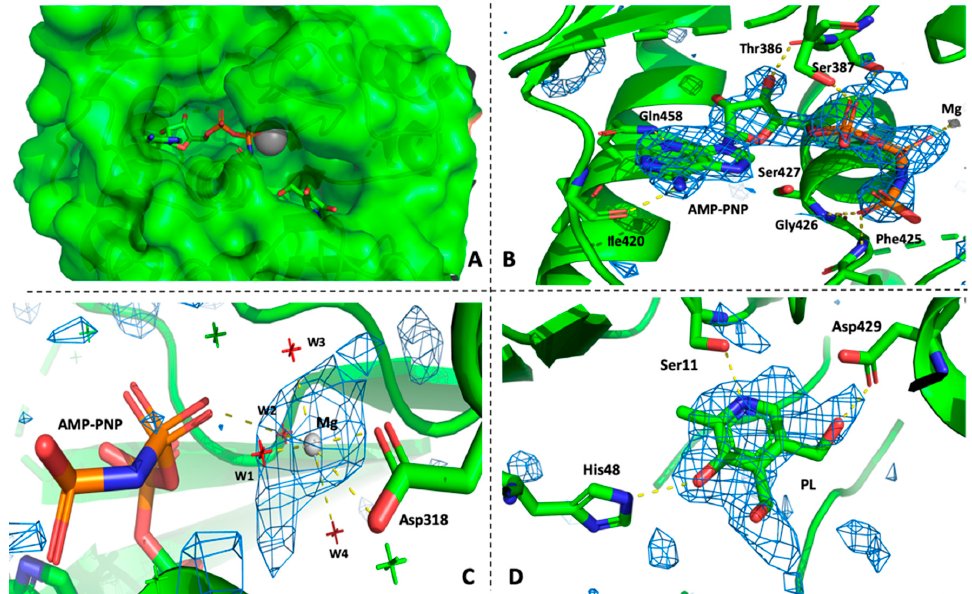
Figure 3. ( A ) Crystal structure of Pf PdxK in complex with AMP-PNP, Mg 2+ ion and PL, Pf PdxK is shown in the surface representation and three ligands located deep inside the pocket; The Fo-Fc omit map of AMP-PNP ( B ), Mg 2+ ( C ) and PL ( D ) within the Pf PdxK structure. Hydrogen bonding interactions of AMP-PNP, PL and Mg 2+ with Pf PdxK are shown as yellow dashed lines, the four red labeled water around Mg 2+ in (C) help to coordinate AMP-PNP and Mg 2+ ion in the pockets.